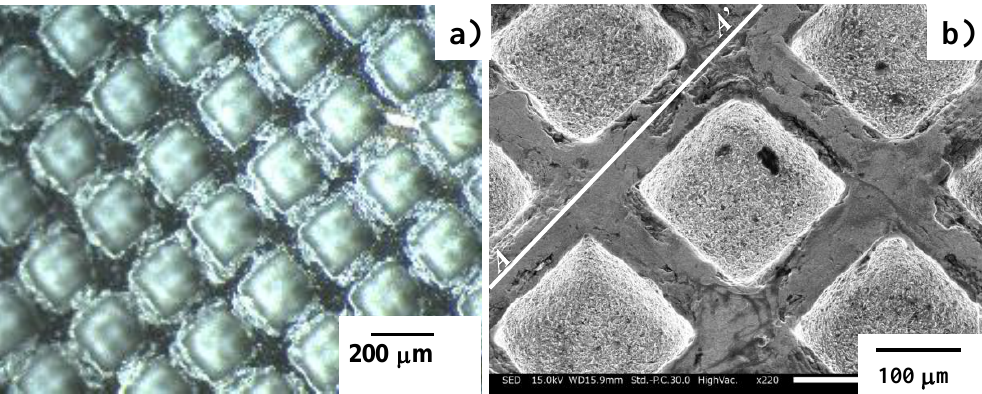
Figure 9. Microscopic view of the multi-punch array. ( a ) Optical microscopic image in wide range of the micro-meshed punch array and ( b ) the SEM image in narrow.